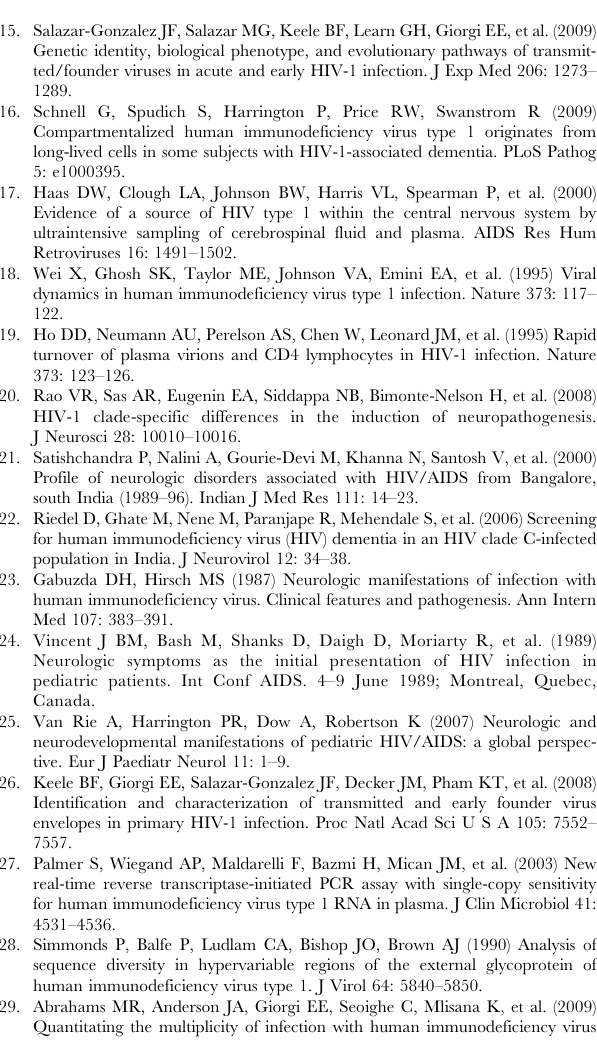
Figure S5 Equilibrated subject 4055 exhibiting two transmitted viruses. Phylogenetic and sequence analysis of plasma and CSF HIV-1 populations for subject 4055. (a) Neighbor-joining tree. Sequences from the CSF are labeled with solid blue circles, and plasma sequences (PL) are labeled with solid red triangles. Bootstrap values $ 40 are indicated ( * ) at the appropriate nodes. Genetic distance is scaled at the bottom of the figure (0.001) and indicates the number of nucleotide substitutions per site between env sequences. The subject’s age is noted, as well as the overall TMRCA. (b) Highlighter plot of aligned env plasma and CSF sequences, generated at www.hiv.lanl.gov. The high- lighter plot characteristics are the same as those stated in Figure S2. Subject was likely infected with 2 viral variants during transmission. The two sequences that are likely closet to the parental strains are CSF_16 and PL_4, and recombination between the transmitted viruses appears to account for much of the env genetic diversity detected in both the plasma and CSF populations. Both variants were maintained within the blood and